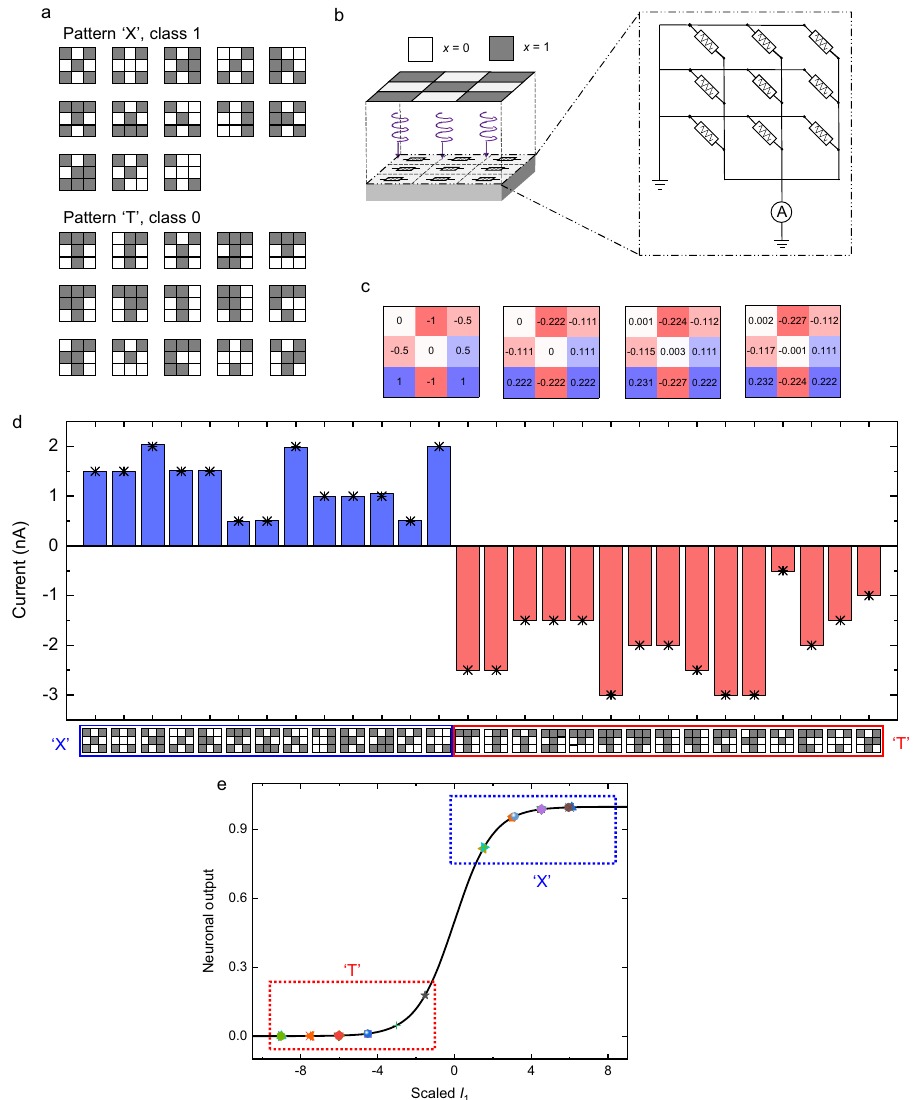
Fig. 5 Implementation of pattern classi fi cation. a Two sets of patterns representing letters ‘ X ’ and ‘ T ’ . b Schematic diagrams showing the operation and the circuit structure of a 1 × 9 FE-PS-NET. The 9 FE-PSs are illuminated following the signals translated from the input pattern. c From left to right: theoretical dimensionless weights, theoretical photoresonsivities scaled from dimensionless weights, actual photoresonsivities right after programming, actual photoresonsivities after pattern classi fi cation. The unit of photoresponsivity is mA/W (not shown). d Output currents ( I 1 ) during the presentations of different input patterns. The theoretical I 1 values are indicated by the “ star ” symbols. e Neuronal outputs obtained by feeding the output currents to the sigmoid